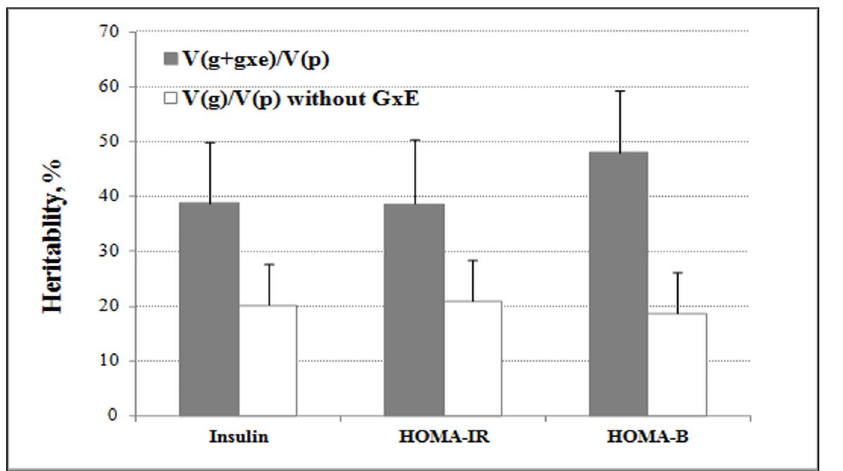
Figure 3. Estimated heritability (%) of type 2 diabetes-related traits. Unfilled bars depict the heritability based on additive genetic variance. Solid bars represent heritability, as a percentage, due to the sum of additive genetic variance and genetic variance by GxE interaction. The corresponding environmental factor for insulin, HOMA-IR and HOMA-B was carbohydrate, carbohydrate, and n-6 PUFA, respectively.